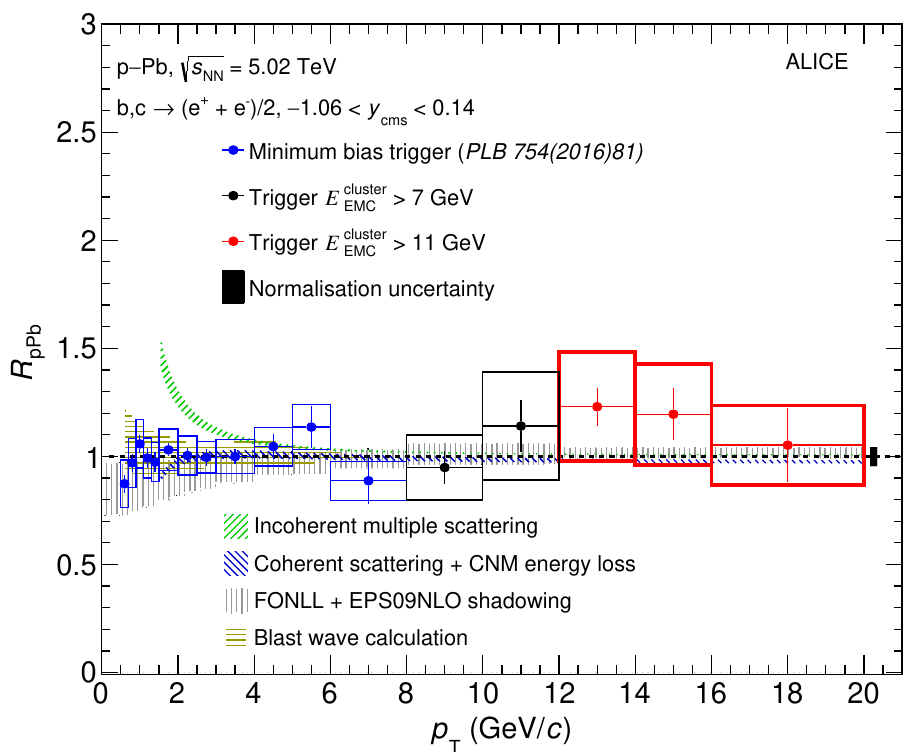
Figure 6 . Nuclear modi(cid:12)cation factor, R pPb , of electrons from heavy-(cid:13)avour hadron decays as a function of transverse momentum for minimum-bias p-Pb collisions at vertical bars represent the statistical uncertainties, and the boxes indicate the systematic uncer- tainties. The systematic uncertainty from the normalisation, common to all points, is shown as a solid box at high p T at R pPb = 1. The published results [33] are updated using the heavy-(cid:13)avour hadron decays measurement obtained by ALICE in pp collisions at above 8 GeV =c are updated and extended using the EMCal trigger. The results are compared with theoretical models [22, 39, 41, 73, 76], as described in the